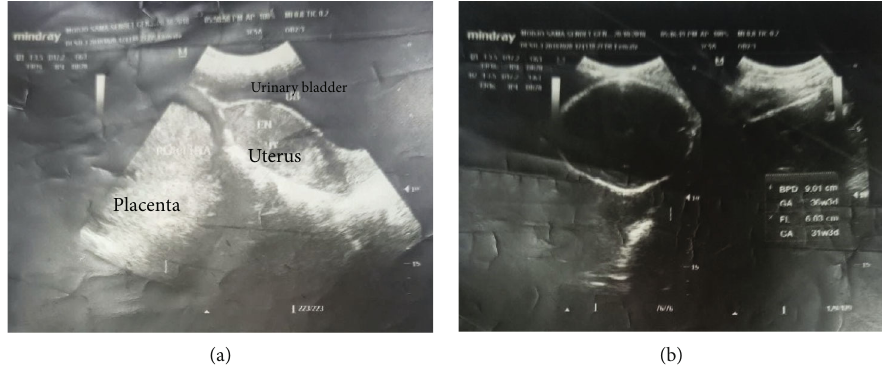
Figure 1: (a and b) Ultrasound fi ndings of abdominal ectopic pregnancy.